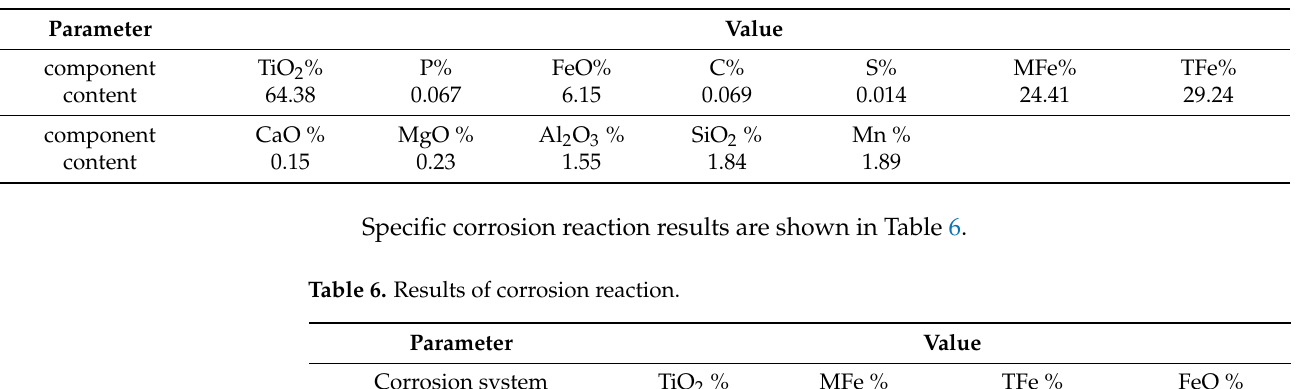
Figure 9. Bubble diameter distribution under different impeller type combinations under 125 rpm. Table 5. Position of monitoring section and monitoring line.